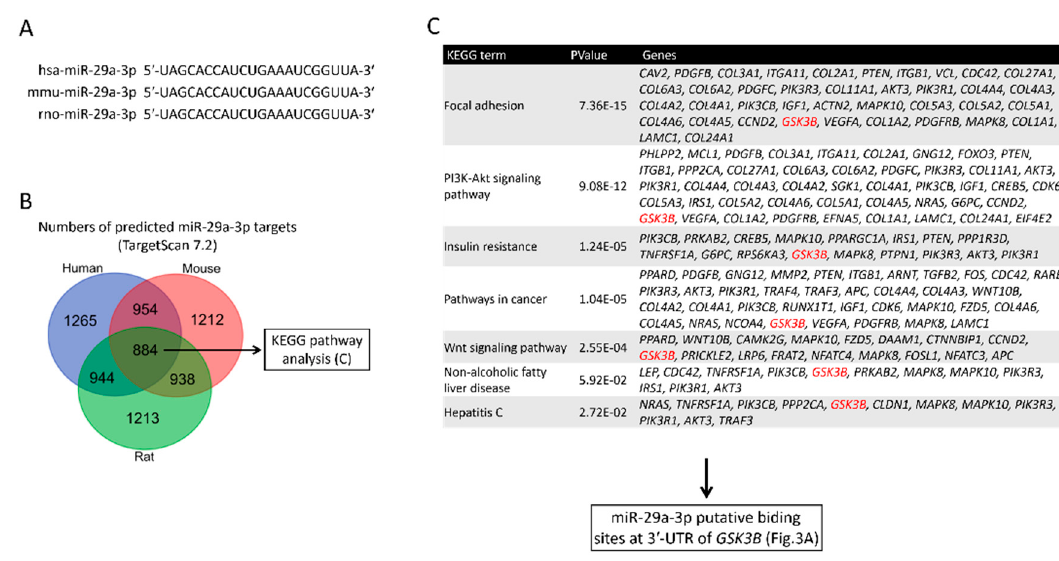
Figure 2. Identification of GSK3 β as a target gene of miR-29a. ( A ) Alignment analysis of mature miR-29a-3p sequences across species. Note that the sequences are all identical across the three species including, homo sapiens (hsa), Mus musculus (mmu), and Rattus norvegicus (rno). ( B ) Putative gene targets of miR-29a-3p were screened by Targetscan7.2. A Venn diagram illustrates numbers of predicted target mRNAs of hsa-miR-29a-3p, mmu-miR-29a-3p, and rno-miR-29a-3p. ( C ) A KEGG pathway analysis of 884 putative miR-29a-3p target genes in humans. Note that GSK3B (highlighted in red) presents in all the pathways and was selected for further assessment.